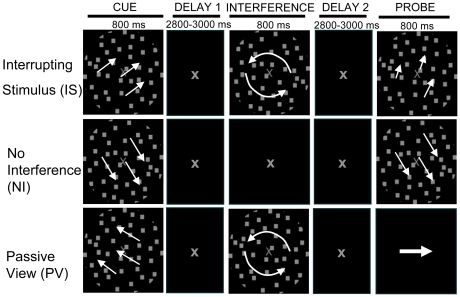
Working memory paradigm.Delayed-recognition paradigm. Working memory for the direction of 100% coherent motion was tested using moving dot kinetograms in two tasks. Participants encoded a direction of motion (cue) and after a delay period determined if the probe direction matched the cue direction. In the Interrupting stimuli task (IS), a circular swirl of motion was presented in the middle of delay period. A button press was required if the swirl was fast. A third task was perceptually equivalent to the WM tasks, but participants were instructed to passively view stimuli and press a right or left button at probe depending on the direction of an arrow.